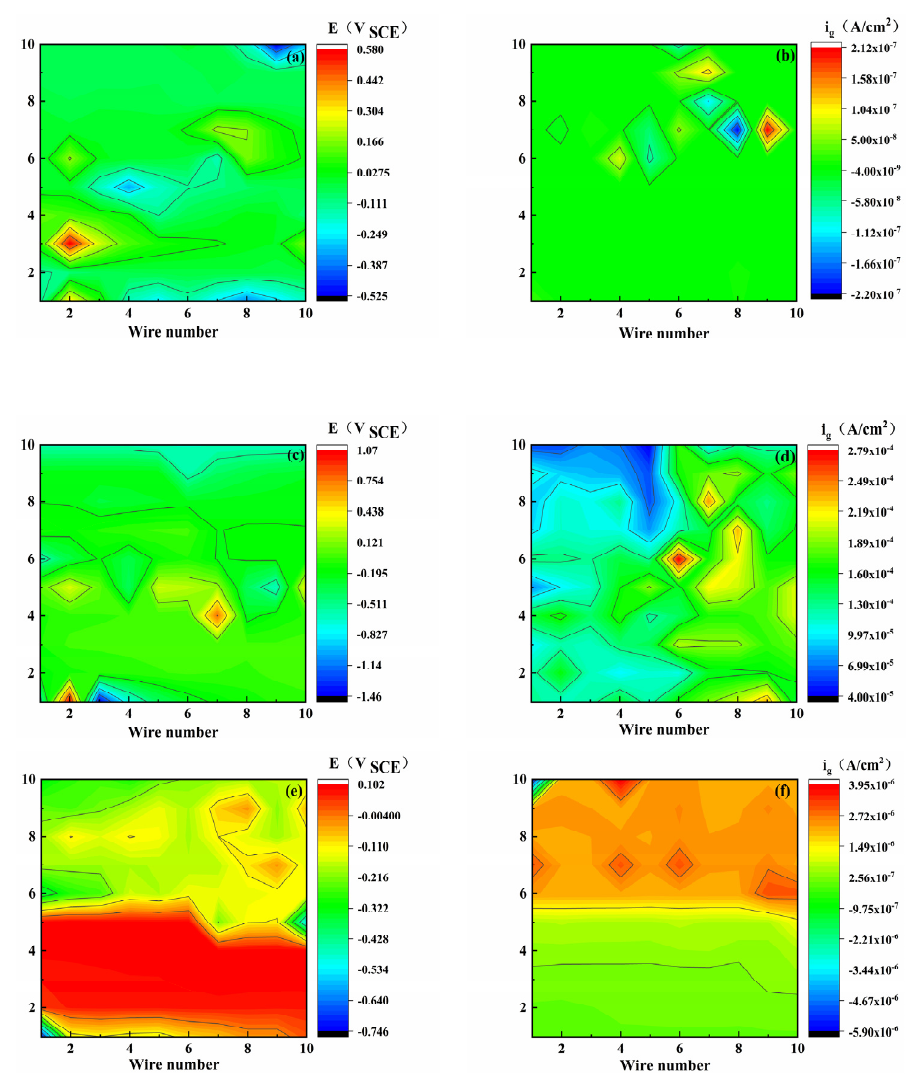
Figure 4. Potential ( E ) and galvanic current density ( i g ) distribution maps of WBE with S8-coating at different pH values (( a , b ): pH 3.10), (( c , d ): pH 5.15), (( e , f ): pH 7.18).